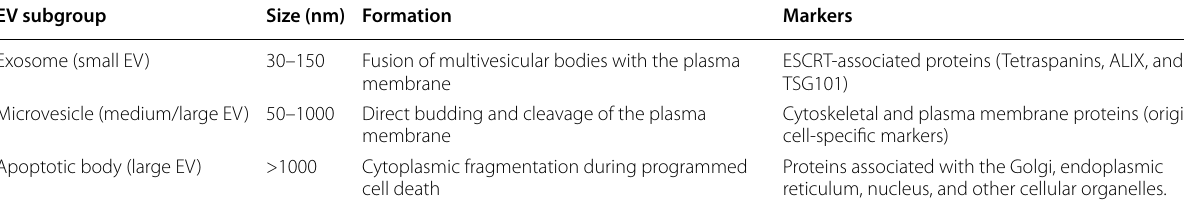
Table 1 Extracellular vesicle subcategories EV